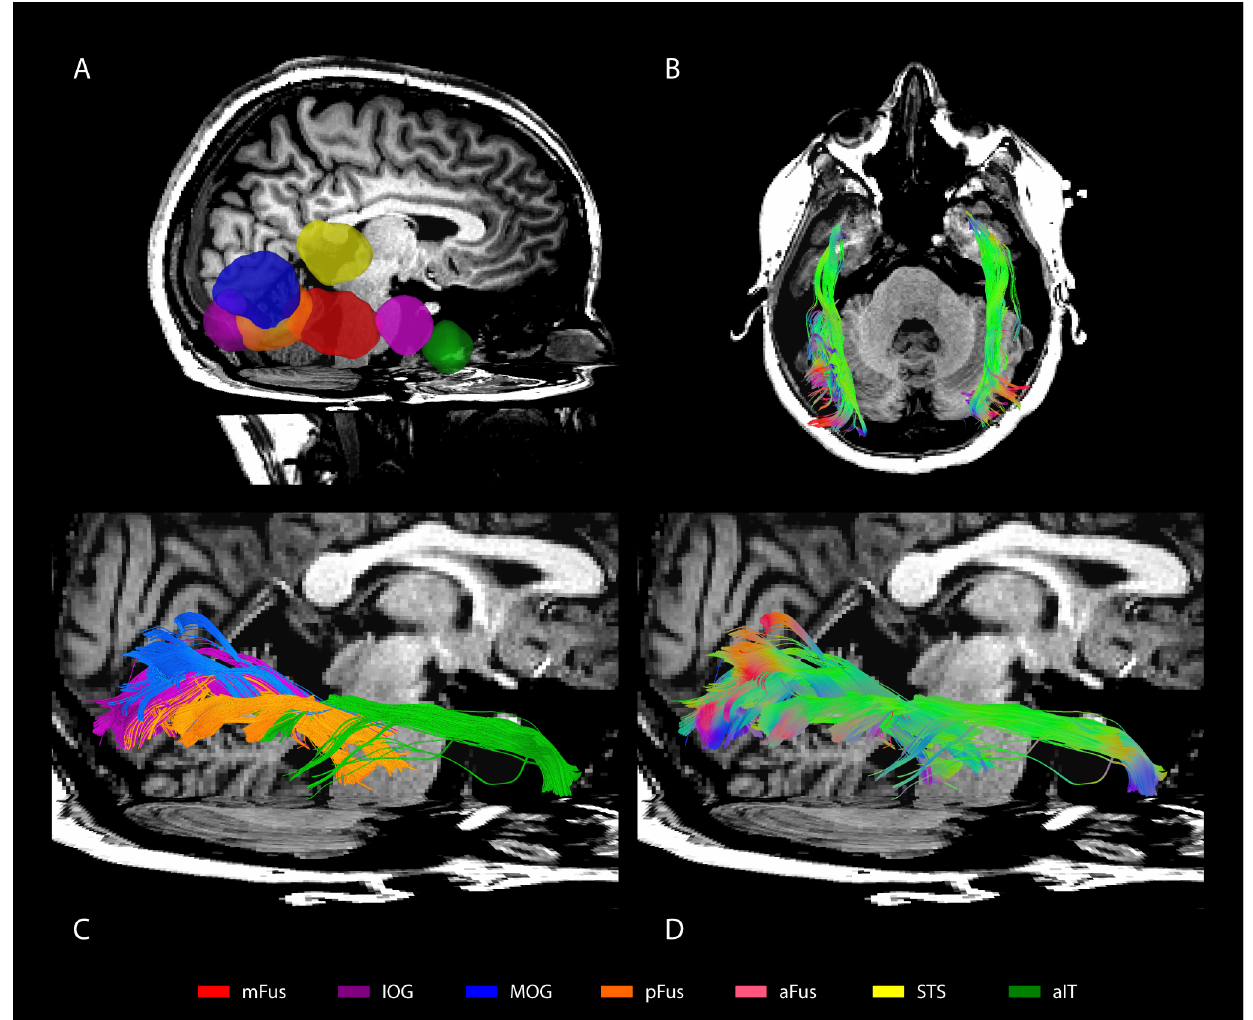
Figure 3. Fiber tracks connecting mFus to other ROIs in a representative participant. a , Expanded right-hemisphere ROIs rendered in 3D space with a high-resolution T1 anatomical co-registered to the diffusion data in the background. b , Fiber tracks connecting bi-lateral mFus to hemisphere respective ROIs shown from above. c , Fiber tracks connecting mFus-R to other ROIs with streamlines colored to correspond to the target ROI. d , The same fiber tracks as in c colored to indicate local directional information.